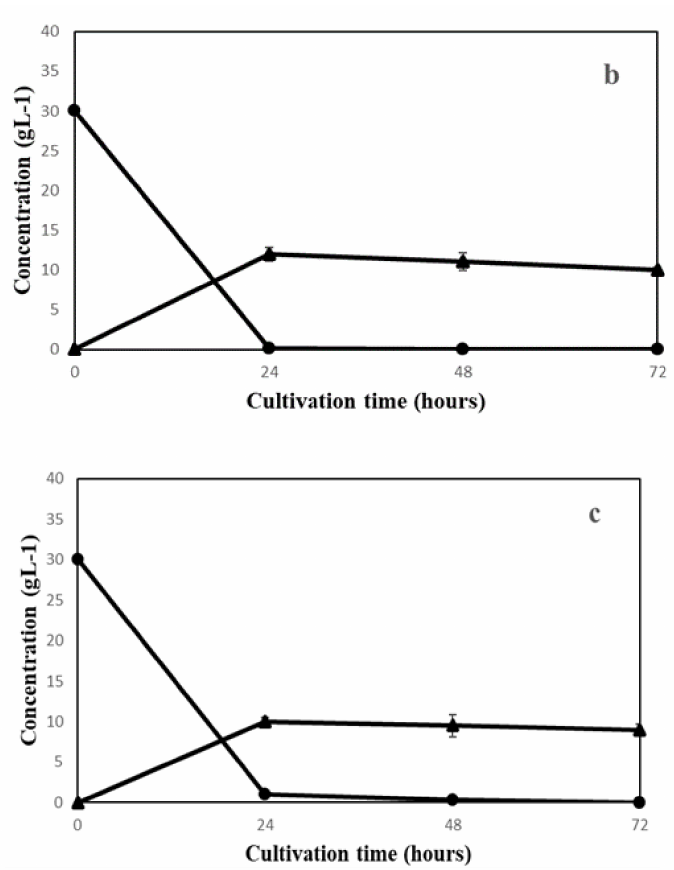
Figure 2. Sugar utilization and ethanol production of ( a ) A. oryzae (pH = 6.5), ( b ) N. intermedia (pH = 5.5) and ( c ) R. oryzae (pH = 5). (glucose ( • ) and ethanol ( (cid:78)